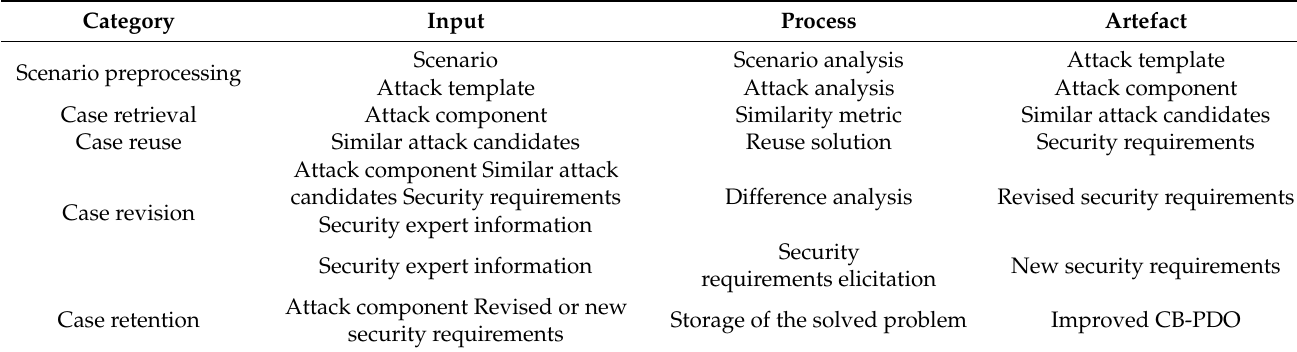
Table 5. Artefacts of each